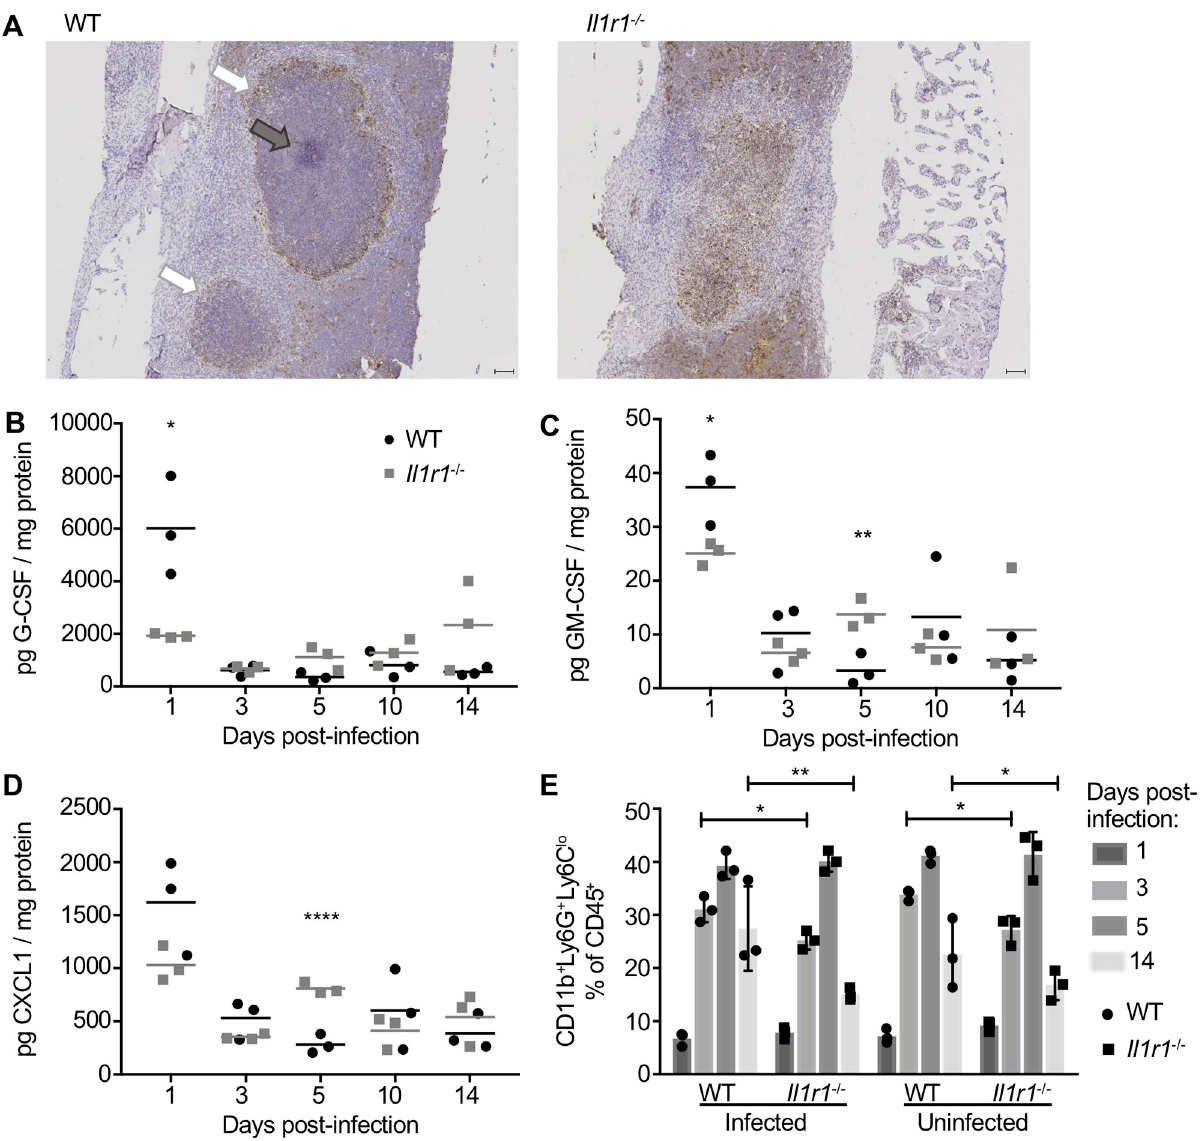
Fig 5. Il1r1 -/- mice have altered abscess structure, delayed granulocytic cytokine levels, and lower neutrophil abundance during S. aureus osteomyelitis. (A) Femurs were harvested from female WT and Il1r1 -/- mice ( n = 5 per genotype) 14 days after S. aureus infection (10 6 CFUs). Harvested femurs were fixed in neutral buffered formalin, dehydrated in 70% ethanol, and decalcified in 20% EDTA before embedding in paraffin for sectioning. The infected femurs were sectioned through the medullary cavity and sections from each femur were stained for myeloperoxidase (MPO) to visualize MPO + (brown) neutrophils and gross abscess architecture in WT (left) and Il1r1 -/- (right) sections. Slides were scanned at 20X using a Leica SCN400 Slide Scanner and images were taken at 4X (scale bars = 100 μ m) and are representative of n = 5 mice per genotype. Abscesses are indicated by white arrows and a S. aureus microcolony by a grey arrow. (B-D) After infection with 10 5 S. aureus CFUs, cytokine levels and relative neutrophil abundance were measured from femurs ( n = 3 per genotype) harvested at days 1, 3, 5, 10, and 14 post-infection (cytokine analysis, B-D) or days 1, 3, 5, and 14 post-infection (flow cytometry, E). Cytokine levels in pg/mL were corrected for overall protein levels in the femur homogenates as measured using a BCA assay. Depicted are select cytokines G-CSF (B), GM-CSF (C), and CXCL1 (D) from WT (black) and Il1r1 -/- (grey) femurs. (E) Relative neutrophil abundance was measured in bone marrow harvested from infected and contralateral, uninfected femurs of WT and Il1r1 -/- mice. Neutrophils are defined as CD45 + CD11b + Ly6G + Ly6C lo and are reported as % of CD45 + immune cells (D). Symbols represent individual data points from each mouse (WT = circles; Il1r1 -/- = squares), horizontal lines or the top of each bar represent the mean, and error bars represent standard deviation. Multiple unpaired t -tests were used to compared pg cytokine/mg protein and neutrophil percentages between WT and Il1r1 -/- mice. � p < 0.05, �� p < 0.01, ���� p < 0.0001. If not denoted with asterisks, statistical difference between genotypes was not significant.